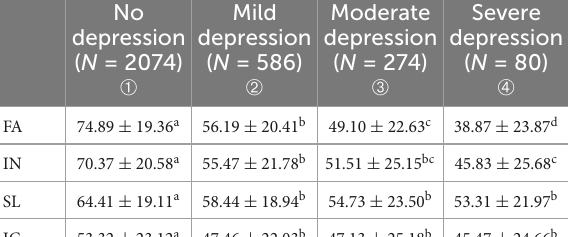
groups except for the mild-to-moderate and moderate-to-severe groups ( p < 0.05). SL and IC were only significantly different between depressed and non-depressed respondents ( p <